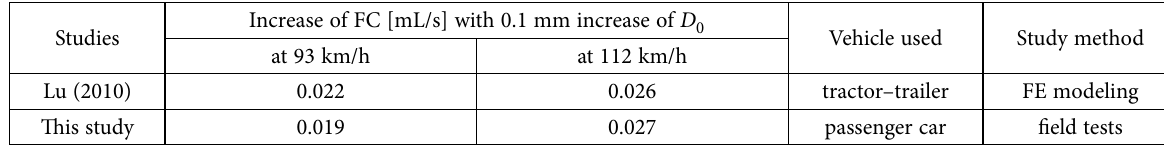
Table 7. Comparison with Lu’s